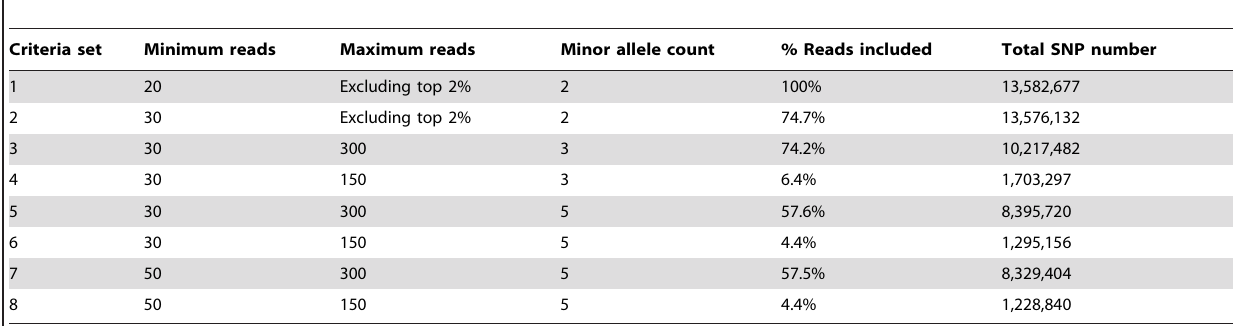
Table 3. Optimization of criteria for SNP identification in channel catfish, including minimum reads, maximum reads and minor allele count.